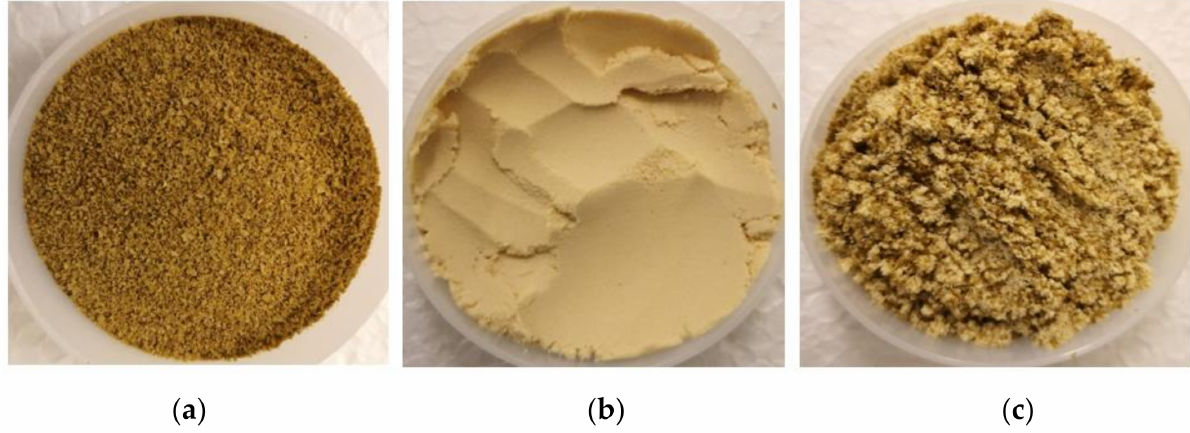
Figure 1. Appearance of three different protein powders: ( a ) RPC; ( b )YPI; ( c ) mixed protein